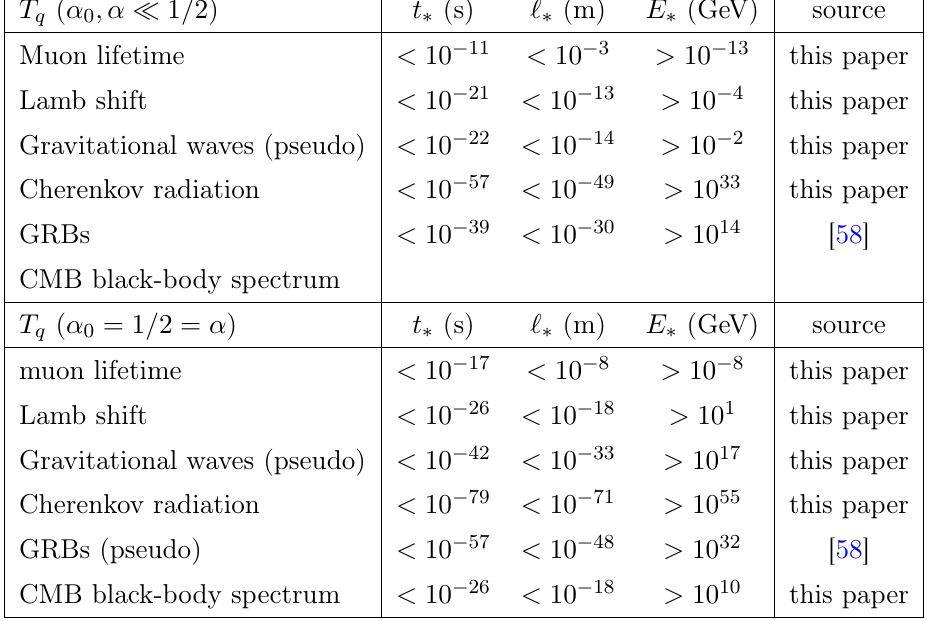
Table 8 . Absolute bounds (obtained for (cid:11) 0 ; (cid:11) (cid:28) 1 , upper part) and bounds for (cid:11) 0 = 1 = 2 = (cid:11) (lower part) on the hierarchy of multifractional spacetimes with q -derivatives with measure (9.2). The key formulæ used to compute the constraints in the table are: for the muon lifetime, t (cid:3) < ( u(cid:14)(cid:28)=(cid:28) (cid:11) 0 ) 1 = (1 (cid:0) (cid:11) 0 ) replacing eq. (139) of [56], with u = 1 ; for the Lamb shift, E (cid:3) > f u(cid:14)E= [(2 (cid:0) 0 (cid:11) 0 )(cid:1) E ] g 1 = ( (cid:11) 0 (cid:0) 1) j E 2 S j replacing eq. (142) of [56], with u = 2 (cid:0) (cid:11) 0 ; for gravitational waves, eq. (9.7) with u (cid:22) / C (cid:22) = (3 (cid:0) (cid:11) (cid:22) ) and 2 C (cid:22) = 1 ; for GRBs, eq. (9.9) [ u = O (1) ]; for Cherenkov radiation, eq. (9.11) with 2 C (cid:22) = 1 [ u = O (1) ]; for the CMB black-body spectrum, a data fit with eq. (3.5) of [59] with the factor 1 =(cid:11) 0 in the denominator replaced by u = 1 . “Pseudo” indicates bounds obtainable in the stochastic view, where T q is regarded as an approximation of T (cid:13) = (cid:11)